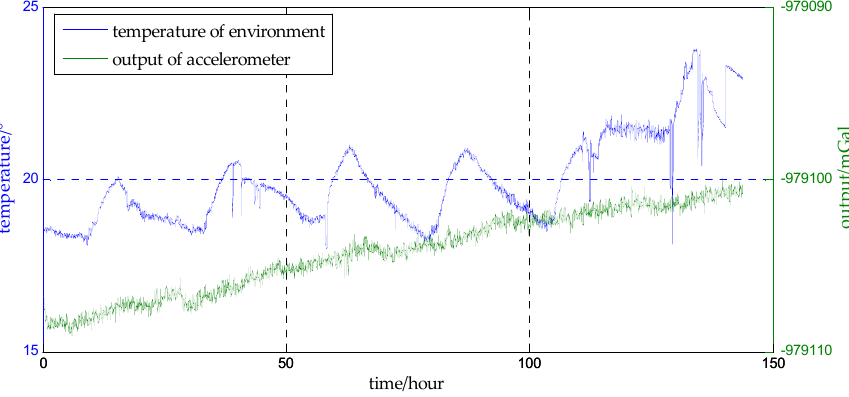
Figure 11. Comparing the temperature of the environment with the output of the accelerometer.